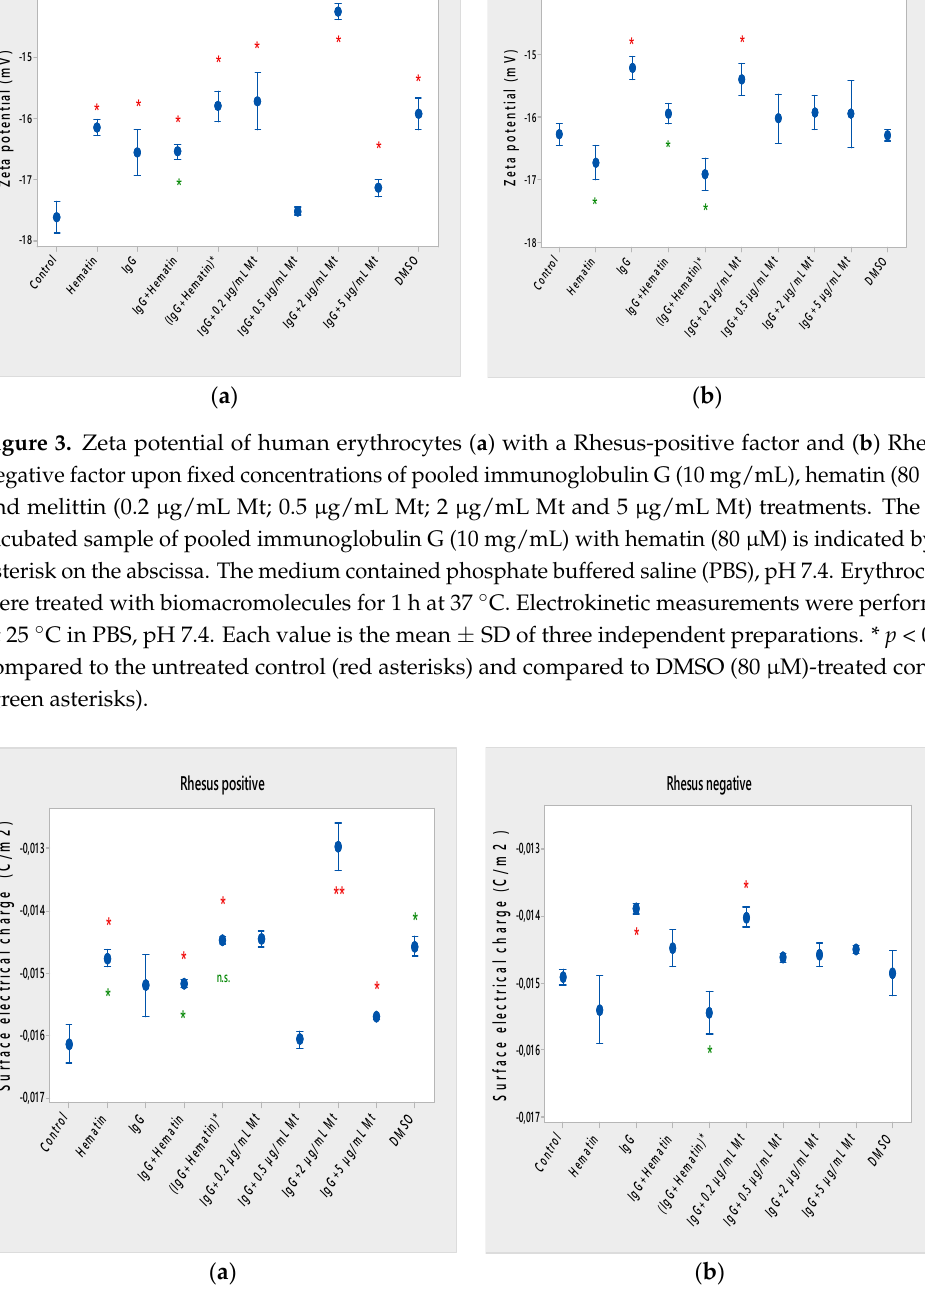
Figure 4. Surface electrical charge of erythrocytes ( a ) with a Rhesus-positive factor and ( b ) Rhesus- negative factor in the presence of pooled immunoglobulin G (10 mg/mL), hematin (80 µ M) and melittin (0.2 µ g/mL Mt; 0.5 µ g/mL Mt; 2 µ g/mL Mt and 5 µ g/mL Mt) in suspending medium of PBS, pH 7.4. The pre-incubated sample of pooled immunoglobulin G (10 mg/mL) with hematin (80 µ M) is indicated by an asterisk on the abscissa. Erythrocytes were treated with biomacromolecules for 1 h at 37 ◦ C. Surface electrical charge measurements were performed at 25 ◦ C in PBS, pH 7.4. Each value is the mean ± SD of three independent preparations. * p < 0.05 compared to the untreated control (red asterisks) and compared to DMSO (80 µ M)-treated sample (green asterisks). 3.5. Lipid Peroxidation of Erythrocytes in the Presence of the pooled Immunoglobulin G, Hematin and Melittin The pre-incubated (IgG+hematin)* preparation significantly affected the electrokinetic parameters of erythrocytes with a Rhesus-positive factor compared to the untreated